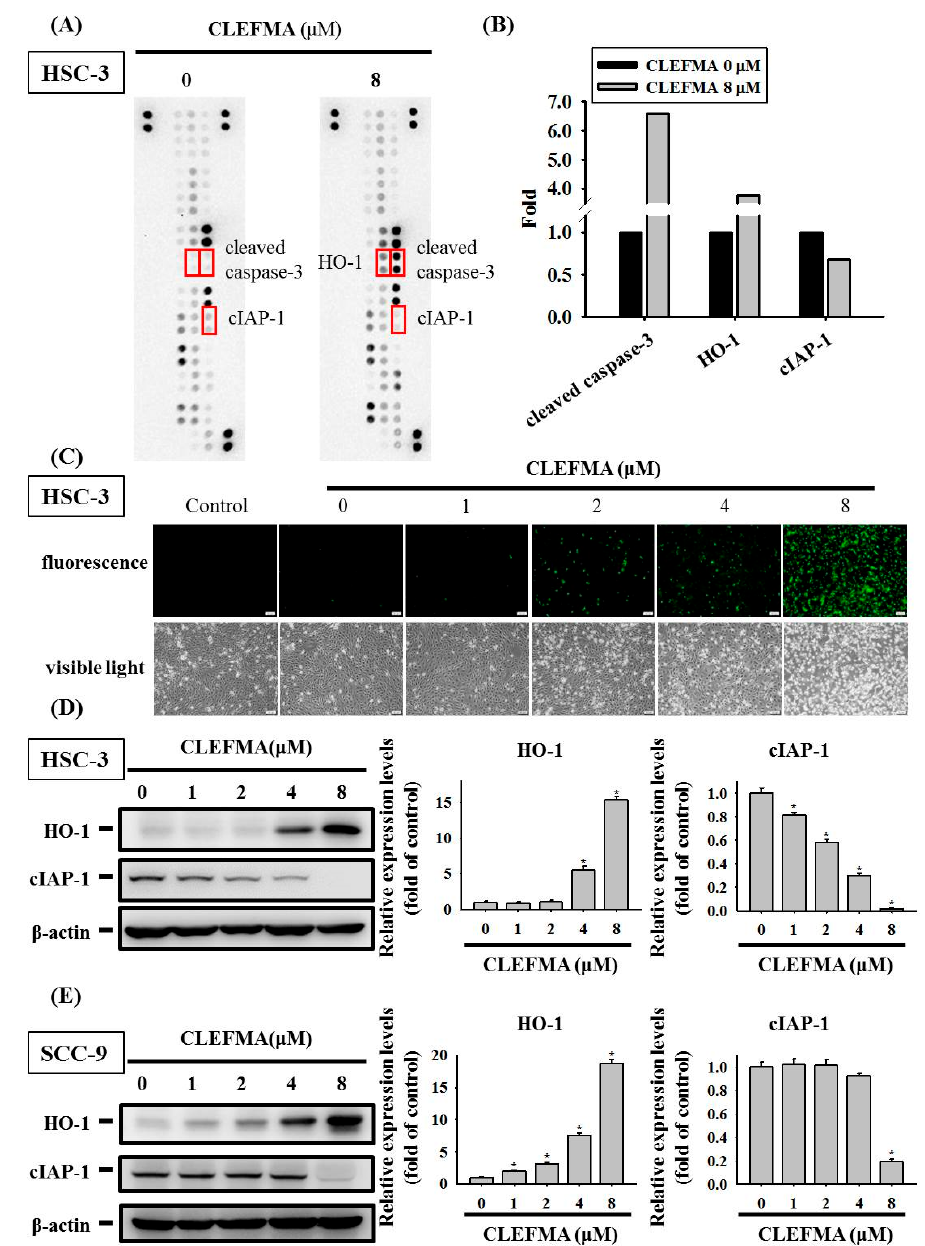
Figure 4. Elevated effects of CLEFMA on caspase-3 activation and HO-1 expression in human OSCC cells. ( A ) HSC-3 cells were incubated for 24 h with 8 µ M CLEFMA and compared with untreated lysate (DMSO control group), and the cell lysates were used to detect 35 different apoptosis-related proteases using the human proteome profiler apoptosis array. ( B ) The quantification of cleaved caspase-3, HO-1, and cIAP-1 from human apoptosis array. ( C ) Live cell imaging apoptosis dye for caspase-3 activity used to detect apoptotic death using fluorescence microscopy with the corresponding filter (green channel). Western blot was performed on HO-1 and cIAP-1 using β -actin as the internal control in ( D ) HSC-3 and ( E ) SCC-9 cells. Quantitative data were acquired from three independent experiments and expressed as mean ± SD. * represent p < 0.05 as compared with the DMSO